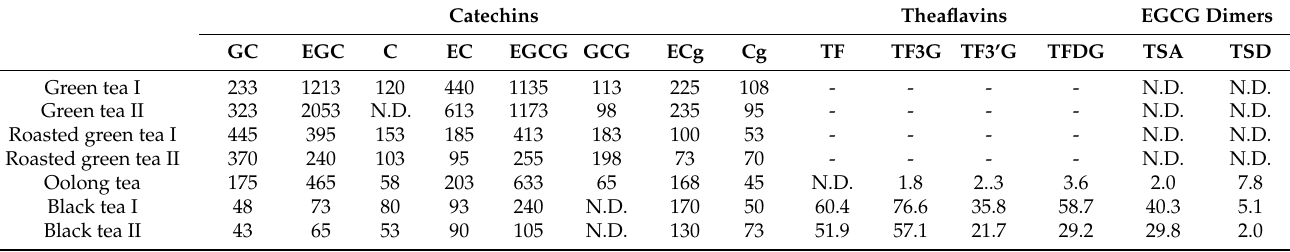
N.D. = not detected. - = not